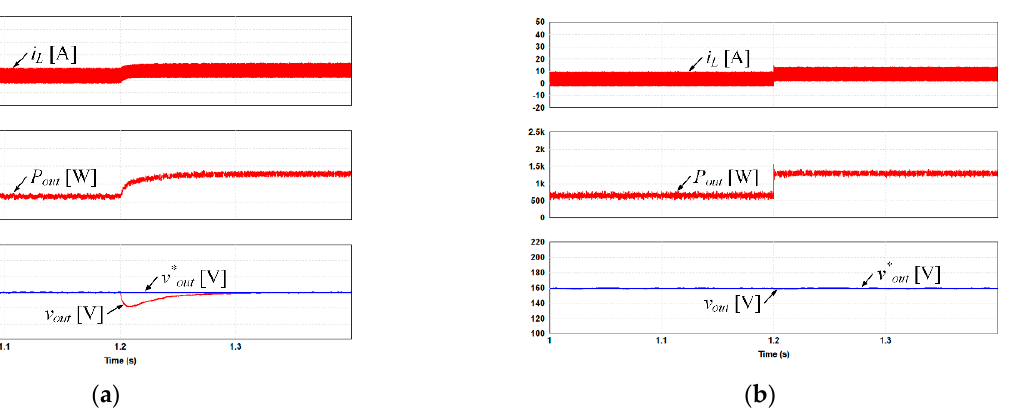
Figure 12. Simulation results of output voltage control of integrated OBC when the load impedance is abruptly changed ( a ) without a feedforward component of output power and ( b ) with a feedforward component of output power.